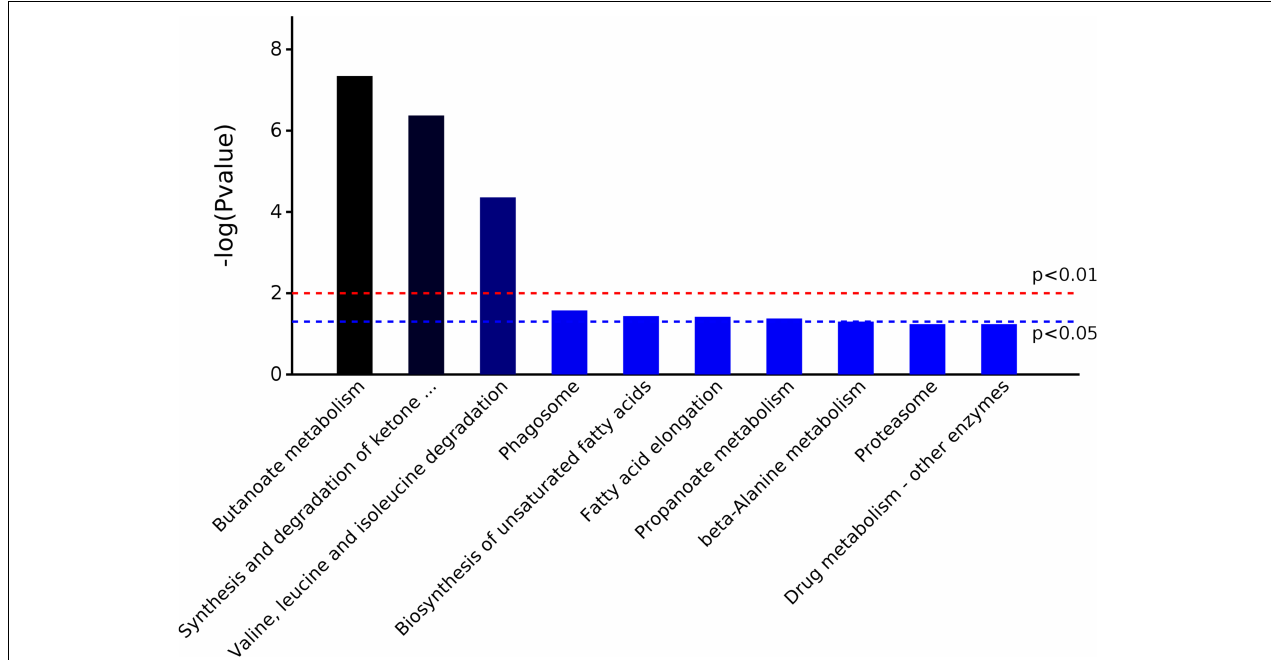
FIGURE 4 | The p -value of enriched KEGG